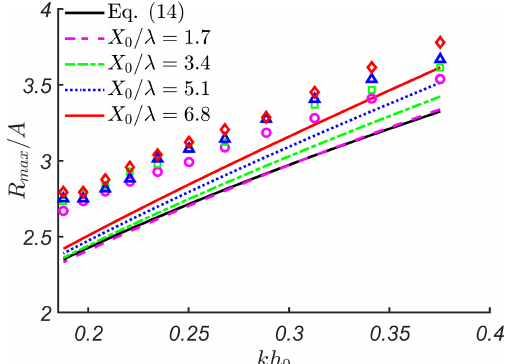
Figure 4. Maximum run-up height, R max /A , as a function of initial wave amplitude, A/h 0 , for different distances to the slope, X 0 /λ . Analytical solution described in Sect. 2 is shown by lines, and nu- merical solution described in Sect. 3 is shown by symbols (dia- monds, triangles, squares and circles) with matching colours. The thick black line corresponds to Eq. (14) for wave run-up on a beach without constant depth section, where kh 0 = 0 . 38.